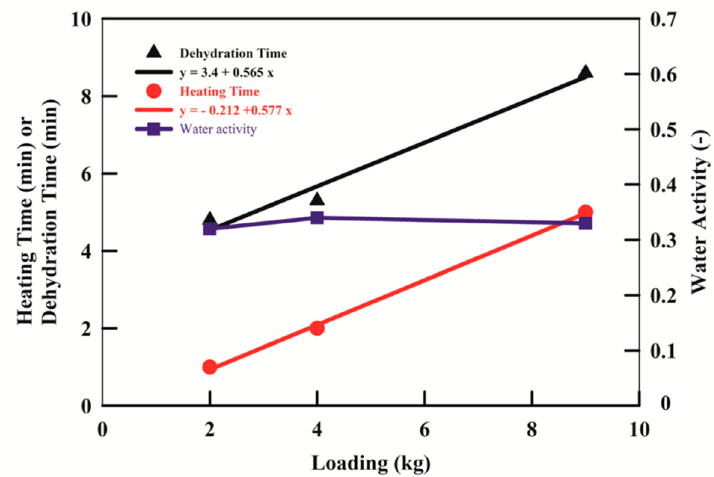
Figure 9. Effect of WG loading on the dehydration time, heating time, and water activity with different loading, from 2 to 9 kg, at 120 °C. Dehydration time ( ▲ ), heating time ( represent the fitting value.